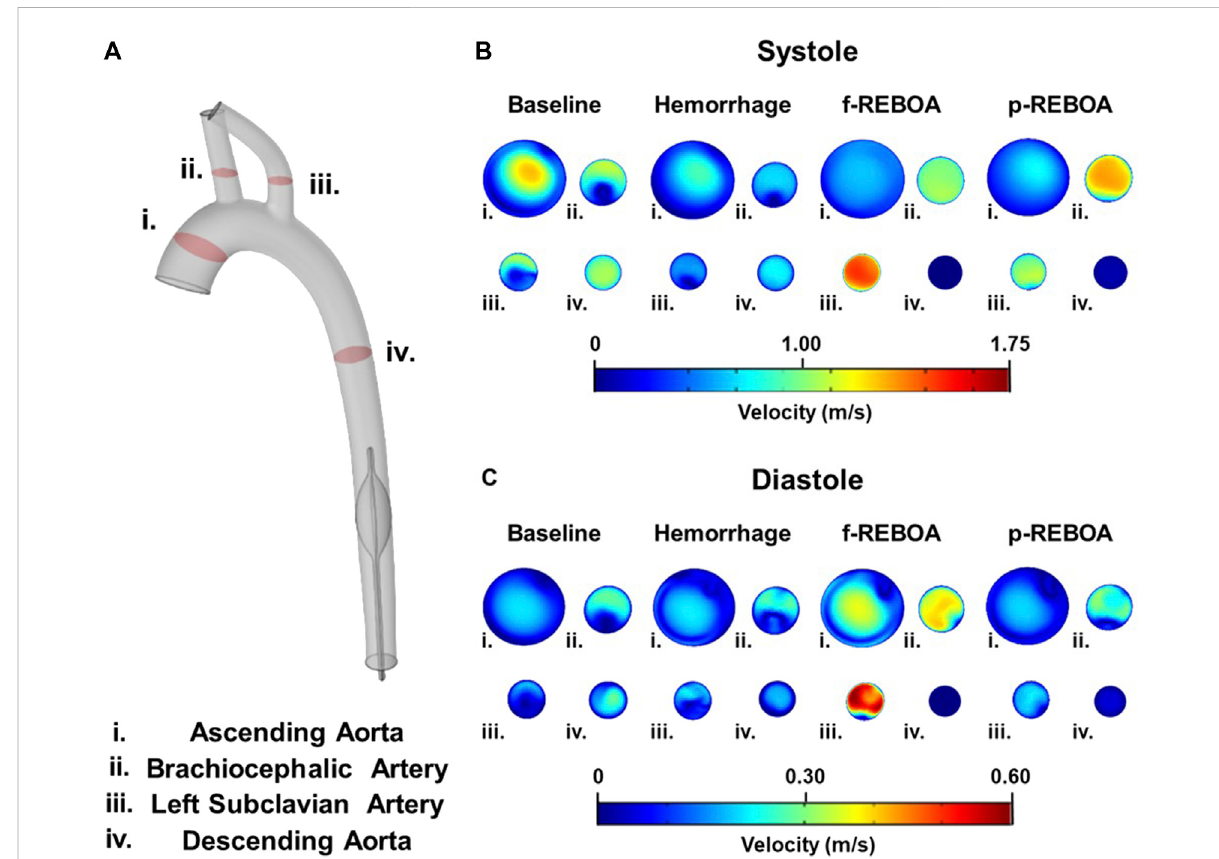
FIGURE 5 Axial fl ow pro fi les from the CFD simulations. (A) Illustration of cut planes used for fl ow visualization in the model. (B) Systolic axial velocity pro fi les are illustrated at baseline, end of 20% hemorrhage, and post f-REBOA and p-REBOA implementation. (C) Diastolic axial velocity pro fi les derived from the computational model are illustrated at baseline, end of 20% hemorrhage, and post f-REBOA and p-REBOA